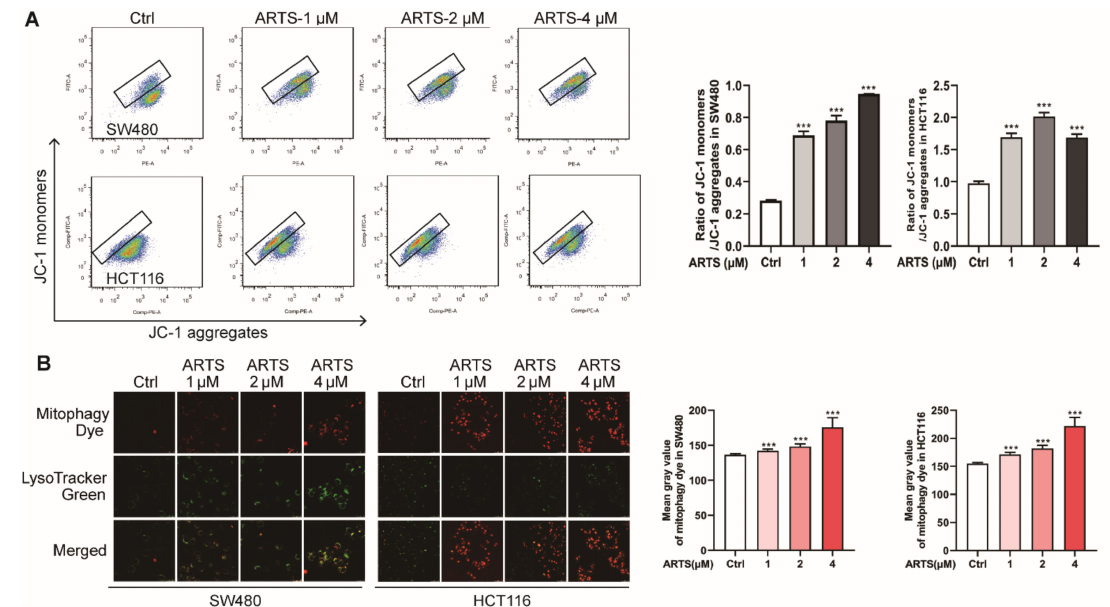
Figure 4. Artesunate promoted mitochondria depolarization and resulted in mitophagy. ( A ) Arte- sunate caused mitochondria depolarization. Cells were seeded in 6-well plates and treated with artesunate (1, 2, 4 µ M) for 24 h and then incubated with JC-1. The average intensity of green fluores- cence from cytoplasmic JC-1 monomers and the red fluorescence from JC-1 aggregates was recorded by flow cytometry. The ratio between JC-1 monomers and JC-1 aggregates represented mitochondria depolarization and the damaged mitochondrial membrane permeability. ( B ) Artesunate induced mi- tophagy in SW480 and HCT116 dose-dependently. Cells were seeded in glass-bottomed dishes. Cells were loaded with mitophagy dye before artesunate treatment. After being treated with artesunate (1, 2, and 4 µ M) for 72 h, images were captured immediately by confocal microscope (Scale bar = 25 µ m). The intensity of red fluorescence was calculated by Image J. *** p < 0.001 vs. Ctrl. Data were shown as mean ±